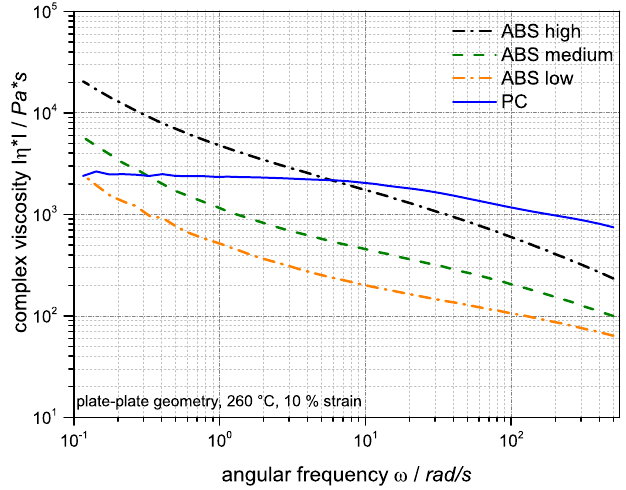
Figure 4. Shear rate dependence of the complex viscosity measured at 260 °C of the neat PC and ABS components used for build-up of the investigated PC/ABS blends.